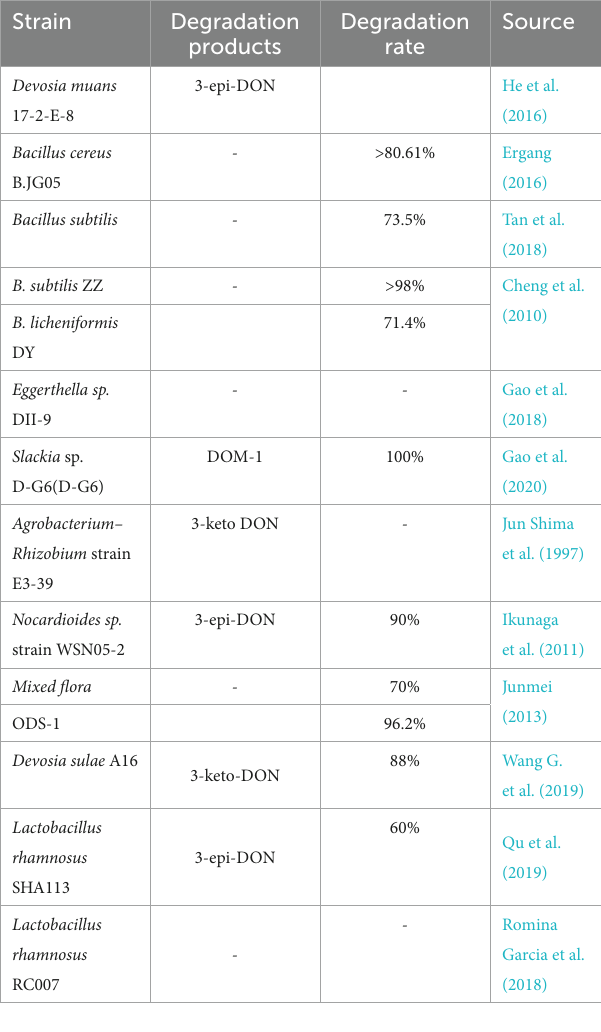
TABLE 3 Study on the adsorption of DON by microorganisms. TABLE 4 Degradation of DON by different